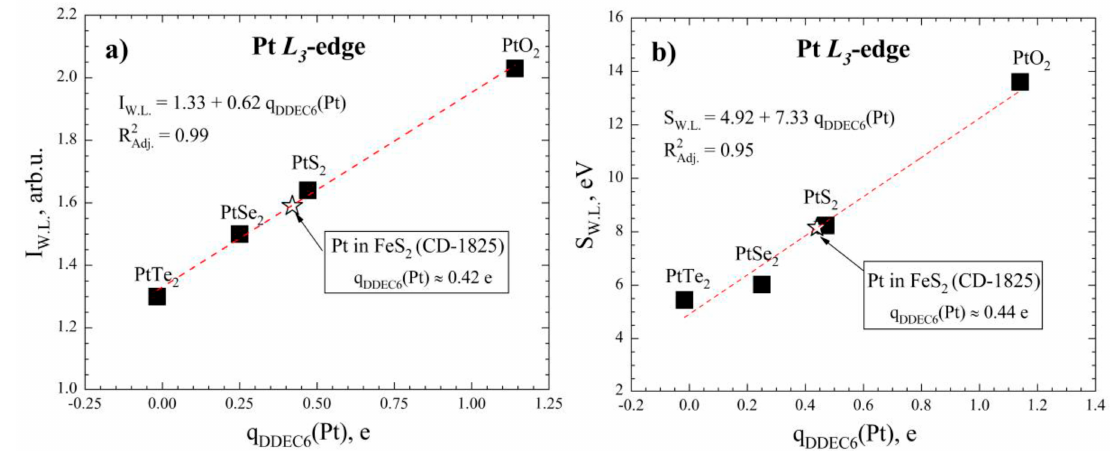
Figure 12. Plot showing the estimated DDEC6 charge of Pt in pyrite (star) using the experimental linear correlation between the white line intensity ( a ), area ( b ) and the DDEC6 charge of Pt.